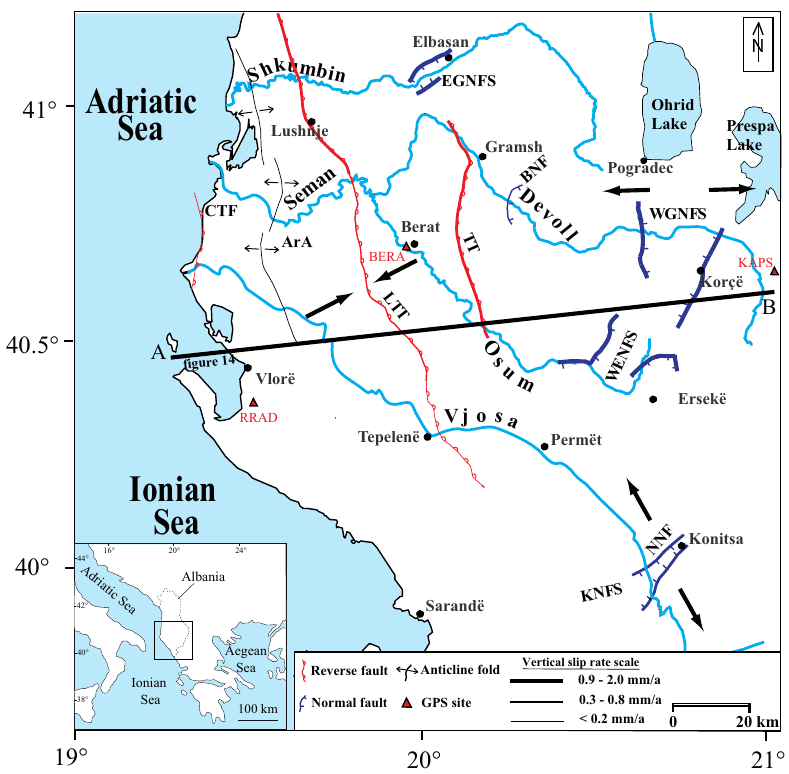
Figure 13. Regional map showing the vertical slip rates of the active faults inferred from incision of river terraces (the whole neotectonic structures inferred in Albania are shown on Figure 1). Thickness of the fault traces is proportional to the valuse of vertical slip rate. Black arrow represents the orientation of the maximum extension and shortening of the present day deformation field of Albania (from Jouanne et al. [2012]). The location of Figure 14 is also shown in the